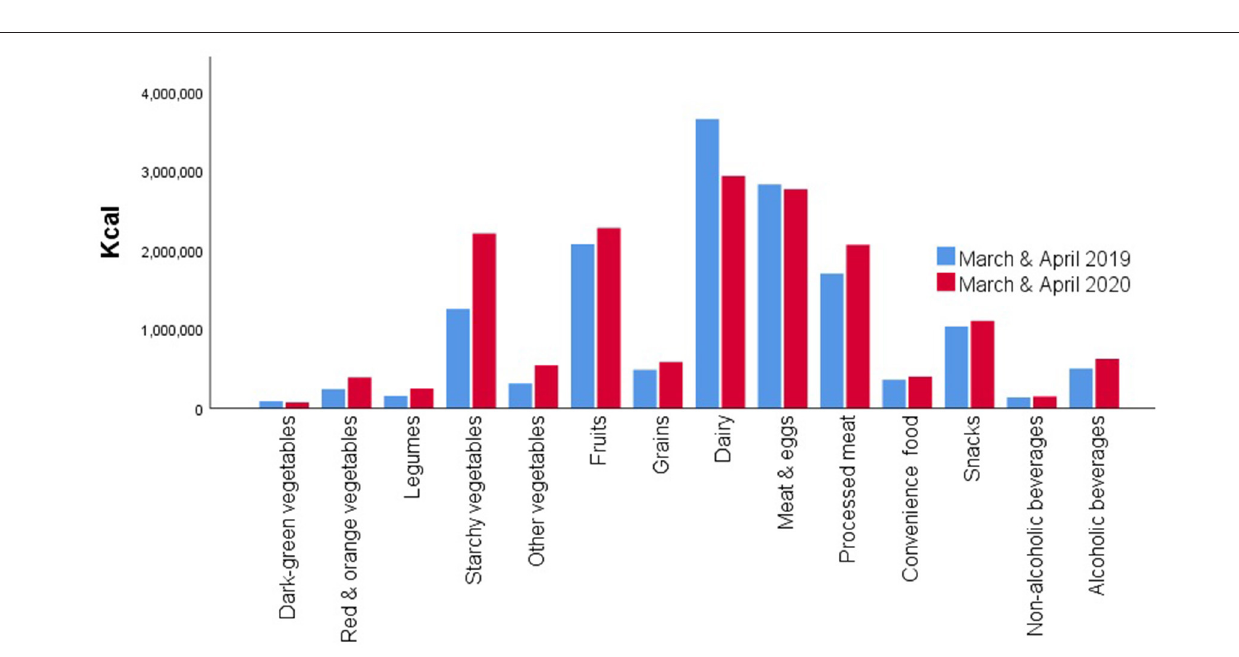
stores in Gallatin County: the store in Bozeman,